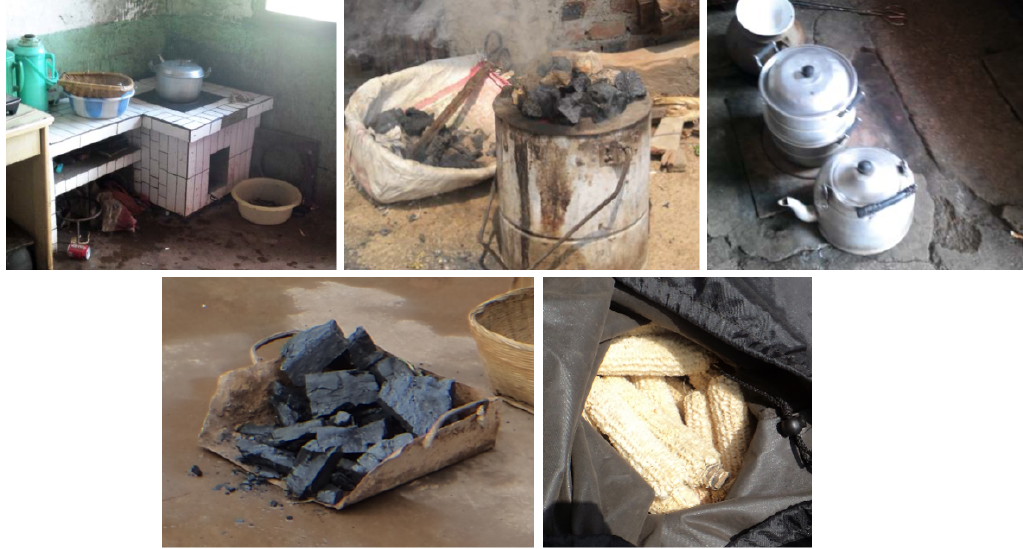
Figure 3. The stove and fuel in Yunnan ( top left : high stove; top middle : portable stove; top right : low stove, bottom left : coal, bottom right :